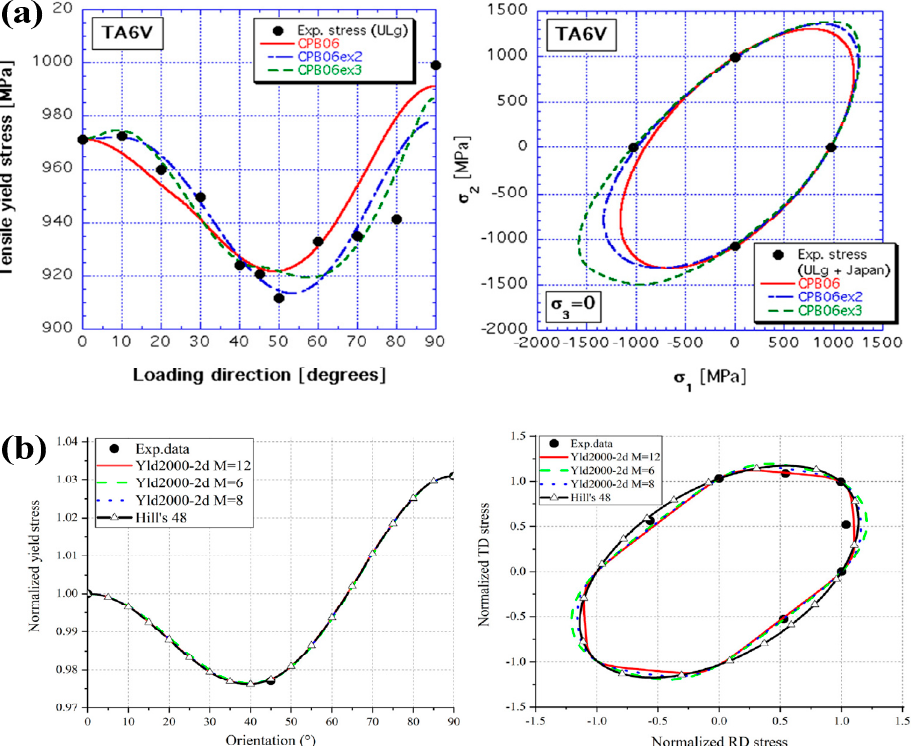
Figure 4. Yield stress and yield loci of Ti-6Al-4V under quasi-static tensile loadings ( a ) at strain rate